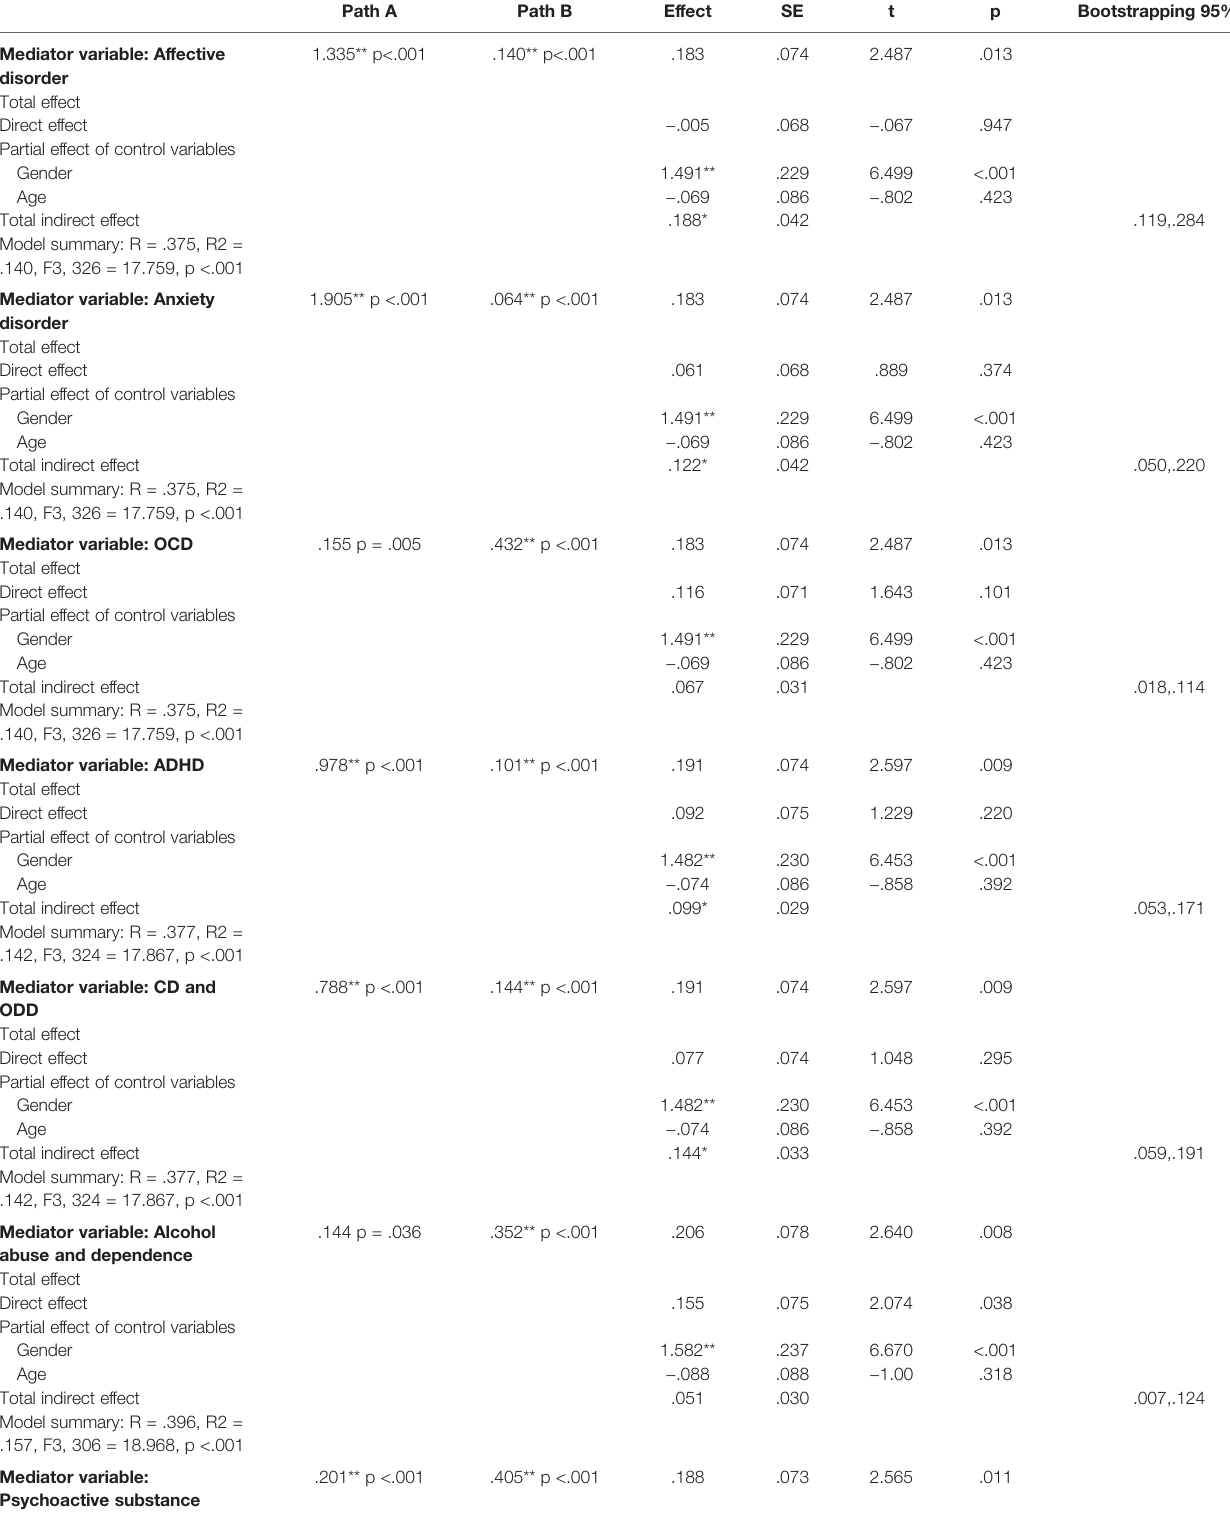
TABLE 6 | Mediation of the effect of internet use on NSSI through mental